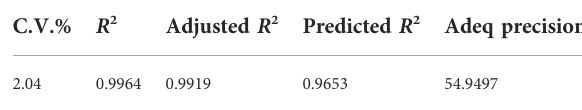
P -value is the probabilityof signi fi cance. The smaller the p -value, themore signi fi cant the effectof the factor on theresponse value. p < 0.0001 indicatesthat theeffect of the factoron the responsevalueisextremelysigni fi cant,denotedby***; p ≤ 0.01indicatesthattheeffectishighlysigni fi cant,denotedby**;0.01 < p ≤ 0.05indicatesthattheeffectissigni fi cant,denotedby*; p > 0.05 indicates that the effect is not signi fi cant.